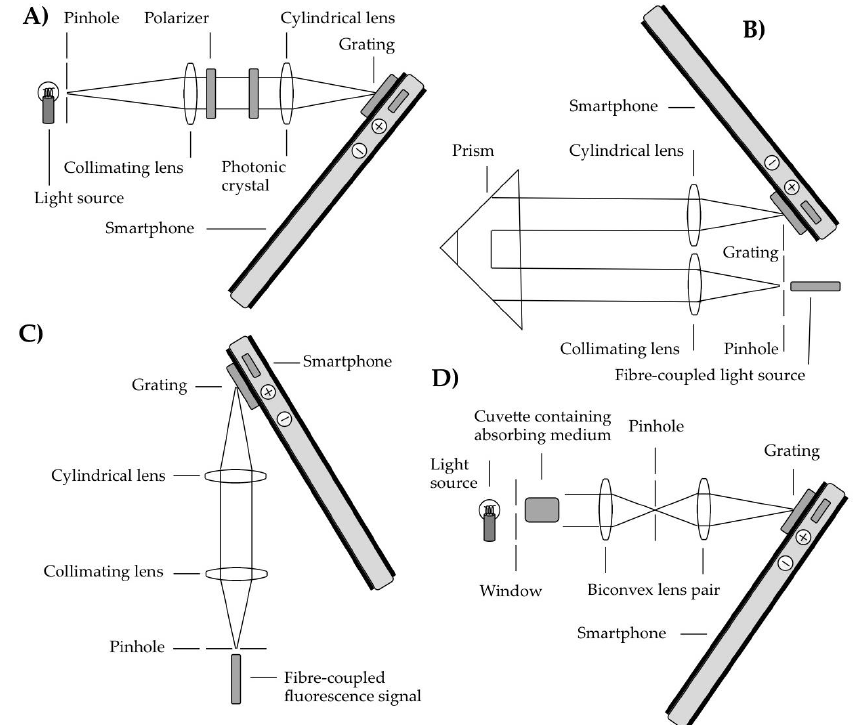
Figure 3. Sample schematics showing the generic operating principles of some transmissive grating smartphone spectrometer designs: ( A ) a configuration involving a pinhole, spherical then cylindrical lens [30,31], in this case shown with a photonic crystal resonant reflection assembly placed in the optical path [30]; in ( B ) a similar approach is adopted, but with evanescent wave absorption measured in the medium surrounding the prism [31]; ( C ) shows a system for measurement of fluorescence spectra, transmitted to the spectrometer, via an optical fibre [33]; in ( D ) absorbance is monitored within a cuvette, with two spherical lenses and a pinhole used to filtered out scattered light and couple radiation to the spectrometer; in this case a DVD section was also used as the diffraction grating [34]. Please see the main text for further detail.